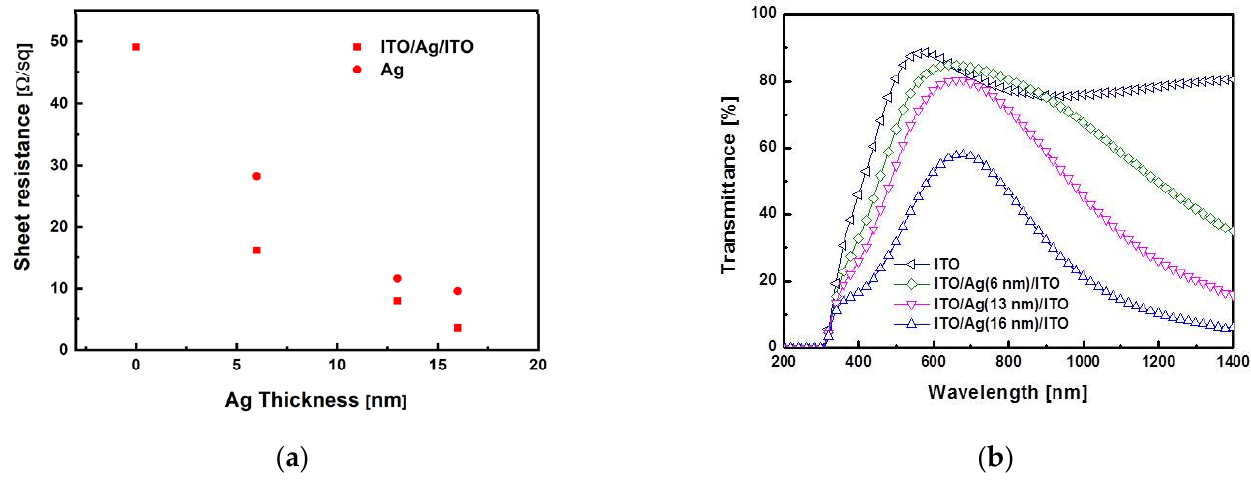
Figure 2. Electrical and optical properties of prepared ITO/Ag/ITO MLs with different Ag thickness: ( a ) sheet resistances and ( b ) transmittances.